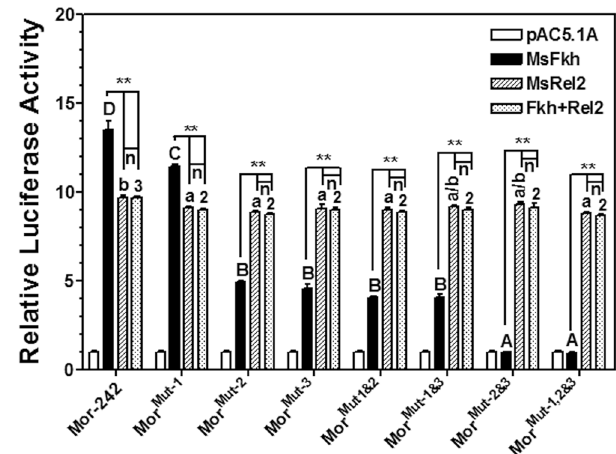
Figure 7. Activation of moricin promoters by MsFkh and MsRel2-RHD independently. The relative luciferase activities of the truncated Mor-242 and its Fkh-binding site mutant promoters activated by recombinant MsFkh or MsRel2-RHD alone, or by co-expression of MsFkh and MsRel2-RHD in S2 cells were determined by Dual- Luciferase ® Reporter Assay System as described in the Materials and Methods. Bars represent the mean of three independent measurements ± SEM. For the activity among different promoters activated by transcription factors (comparing solid bars by MsFkh, stripe bars by MsRel2-RHD, or dotted bars by MsFkh/MsRel2-RHD across the promoters), identical letters (capital letters for solid bars and small letters for stripe bars) or identical numerical numbers (dotted bars) are not significant difference (p > 0.05) while different letters or different numerical numbers indicate significant difference (p < 0.05). Comparing the activity of the same promoter stimulated by different transcription factors (between solid and stripe bars, solid and dotted bars, as well as stripe and dotted bars for each promoter), the significance of difference was also determined by an unpaired t-test ( * p < 0.05; ** p < 0.01), and “n” indicates not